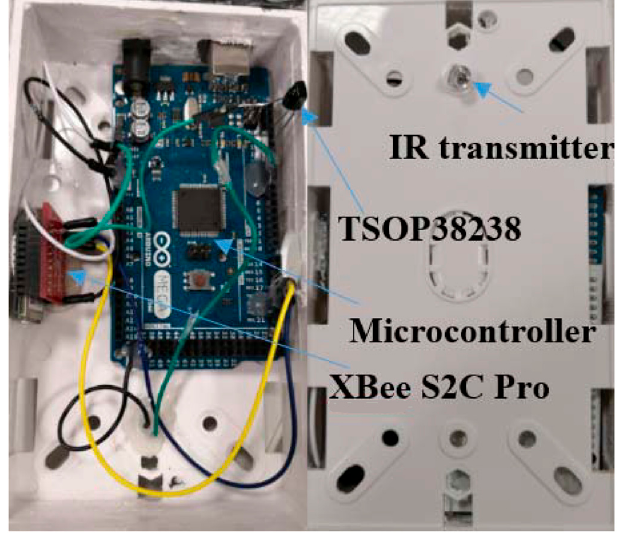
Figure 4. Zigbee-connected infra-red (IR) learner remote